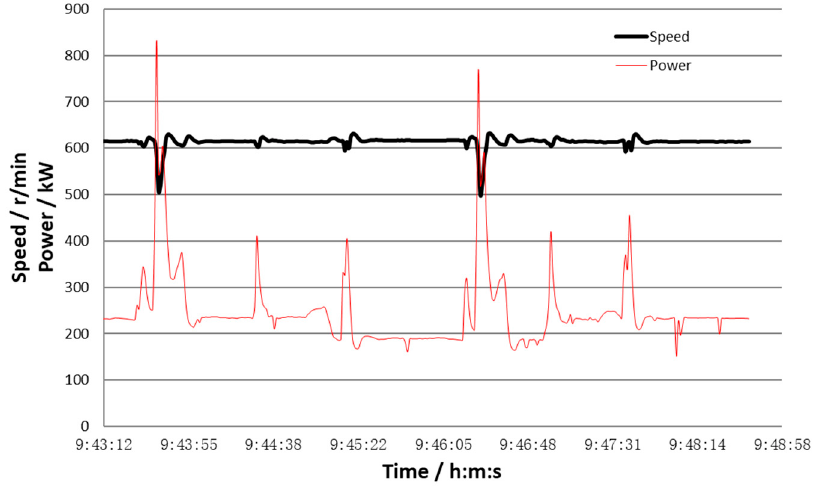
Figure 2. Operating mode of running in the hole.